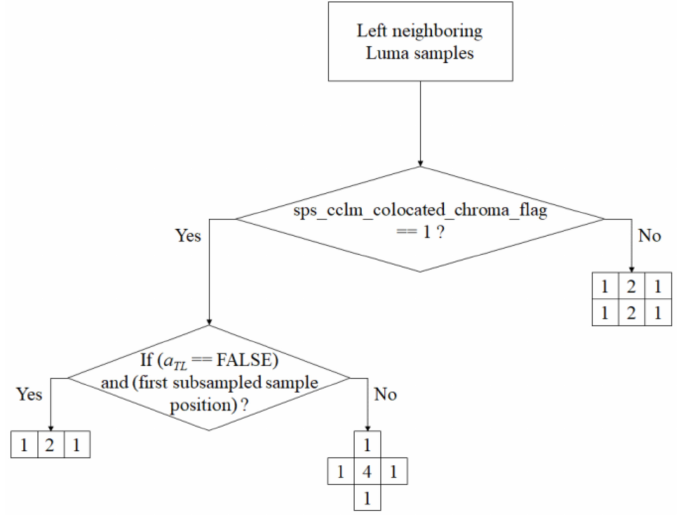
Figure 5. Flow chart of downsampling filter shape selection for left neighboring luma samples in